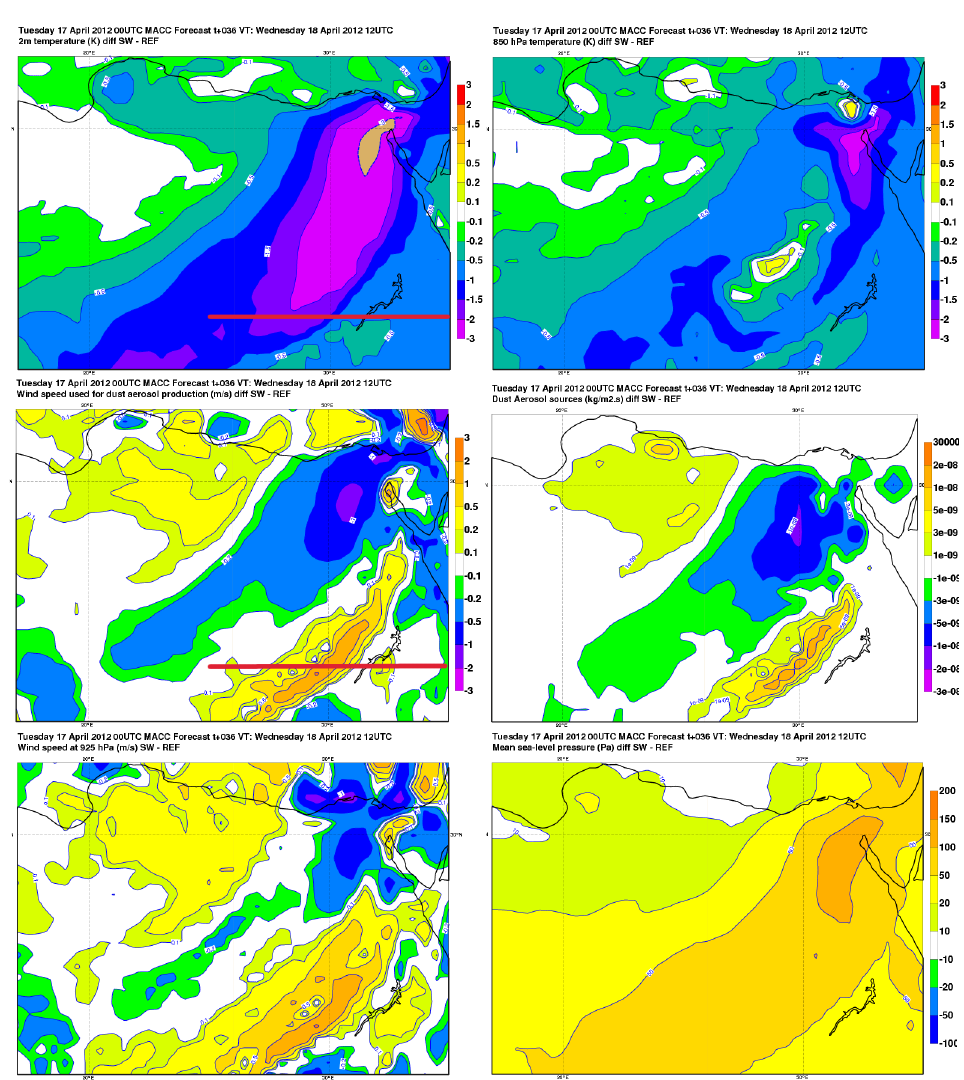
Figure 9. Simulations starting on 17 April 2012, 36h forecast. Difference of SW–REF for 2m temperature (top left), 850hPa temperature (top right), 10m wind speed (middle left), dust production (middle right), wind at 925hPa (bottom left), sea-level pressure (bottom right). The red line on the 10m wind speed and 2m temperature panels indicate the cross section of Fig.